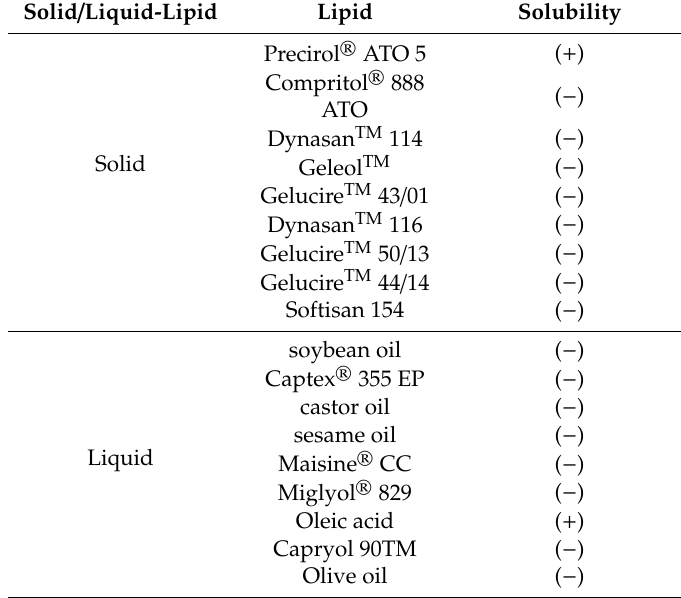
Table 1. Screening of solid and liquid lipids for Ciprofloxacin containing nanostructured lipid carriers (CIP-NLC) (Drug and lipids added in 1:10 ratio; 80 ± 2 ◦ C; under continuous magnetic stirring at 2000 rpm for 10